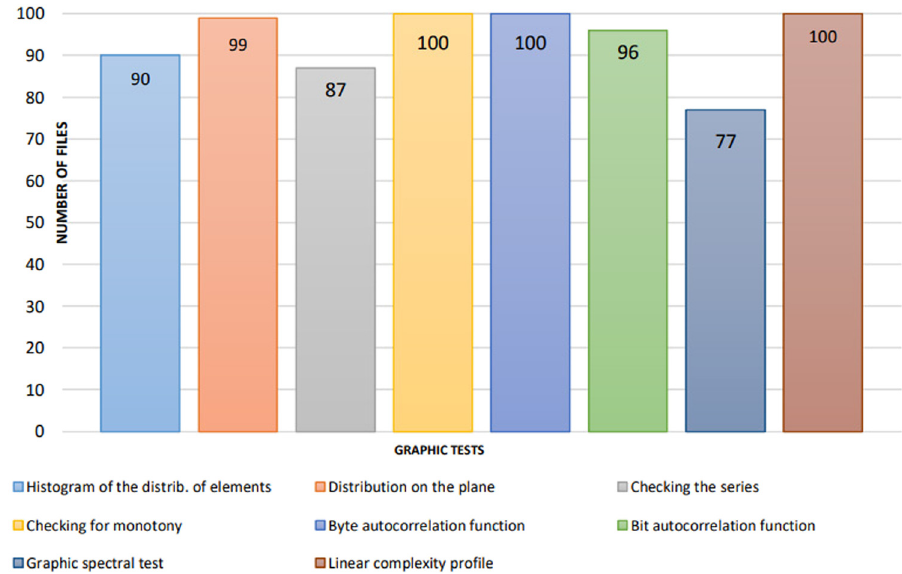
Figure 4: Graphical test results.